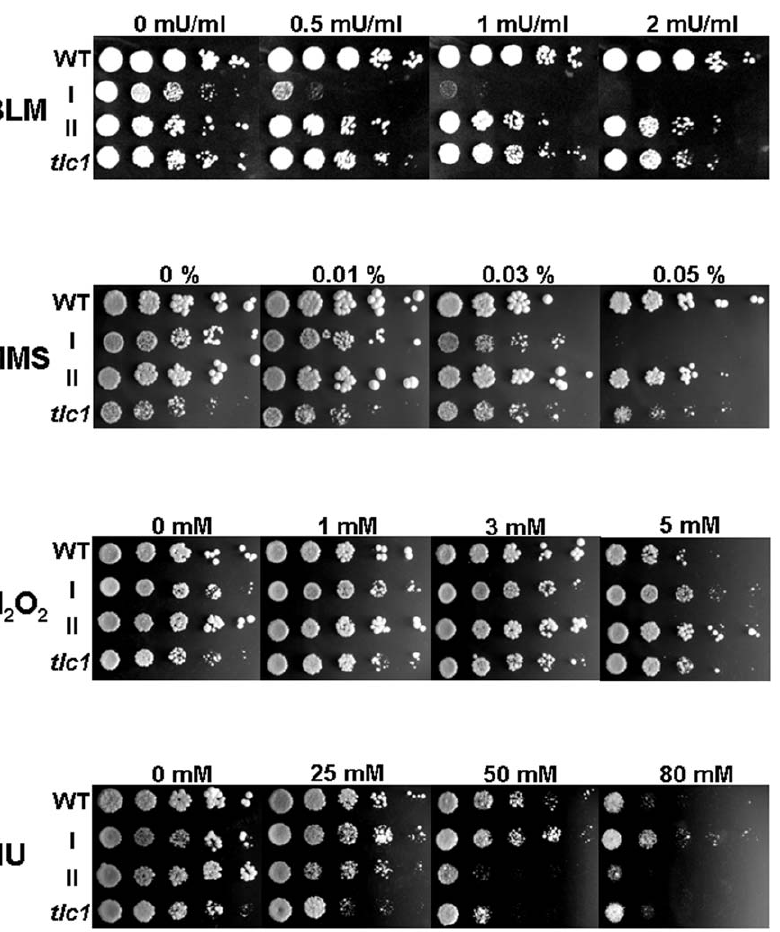
Figure 1. Type I survivors are hypersensitive to DNA-damaging agents. To measure the character of telomerase-minus cells, five-fold serial dilutions of isogenic wild type (WT), pre-senescent tlc1 mutant, type I or type II strains were spotted onto YPD plates containing indicated drugs with denoted concentrations. The plates were incubated at 30 u C for three days before photograph.